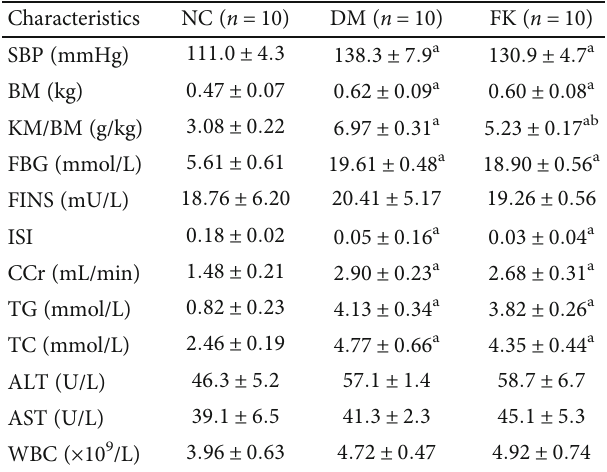
Table 1: General data of rats after 8 weeks of treatment ( mean ± SEM ).